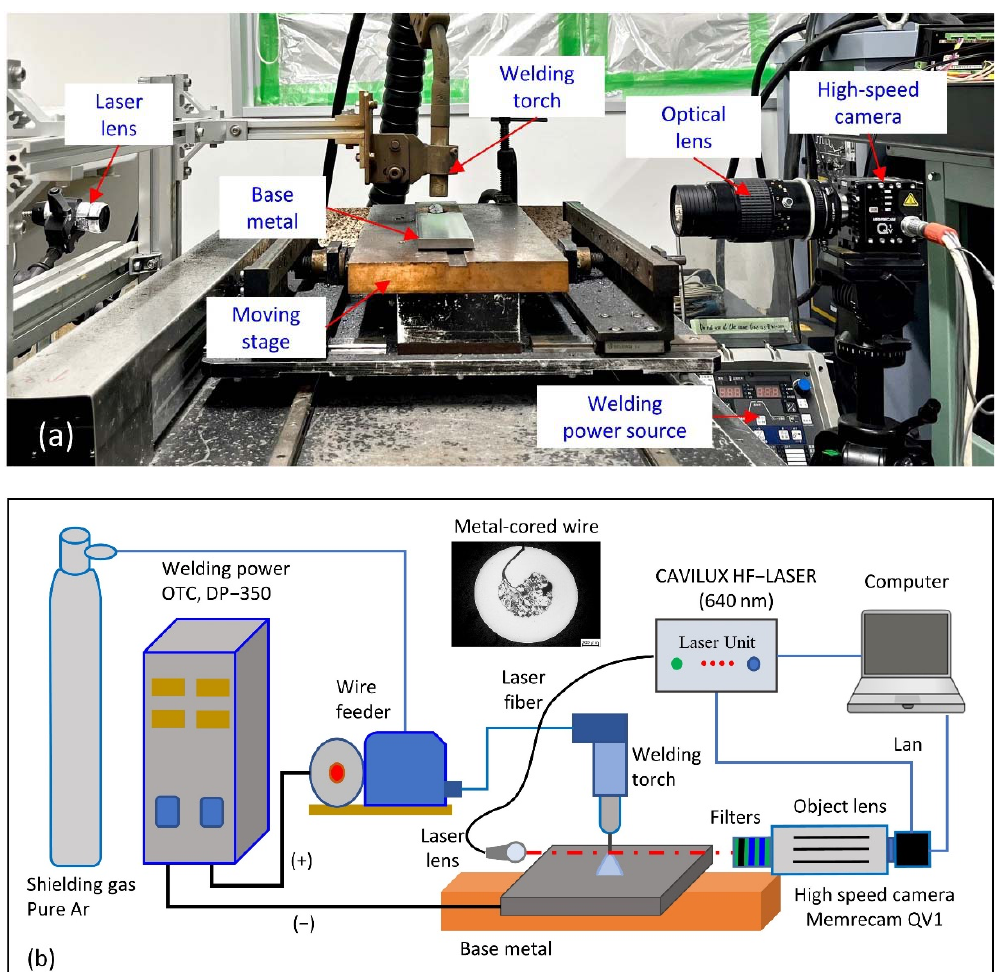
Figure 1. Photo of the experimental setup ( a ) and schematic illustration of experimental apparatus ( b ).